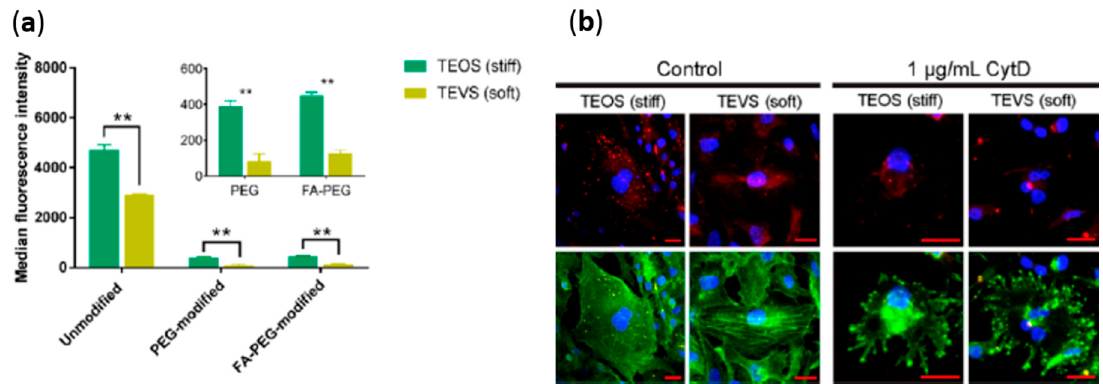
Figure 4. Nanocapsular stiffness effects: ( a ) cellular uptake by RAW264.7 murine macrophages of surface-modified NPs; ( b ) fluorescence micrographs showing the cellular uptake of FA-PEG-modified NPs by CytD-treated SKOV3 cells. (** Indicates statistical significance, p < 0.01). Reprinted with permission from [114]. Copyright 2018 American Chemical